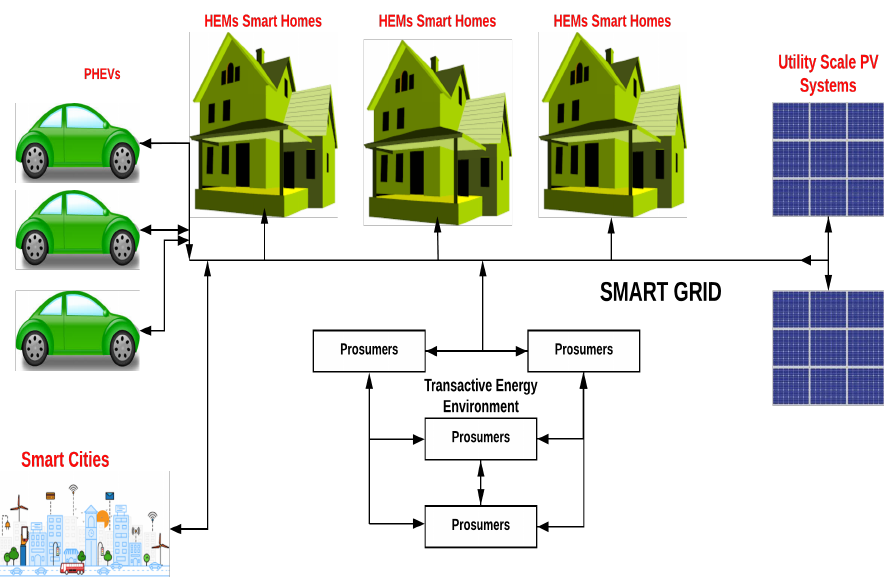
Figure 5. A future scenario with high PV